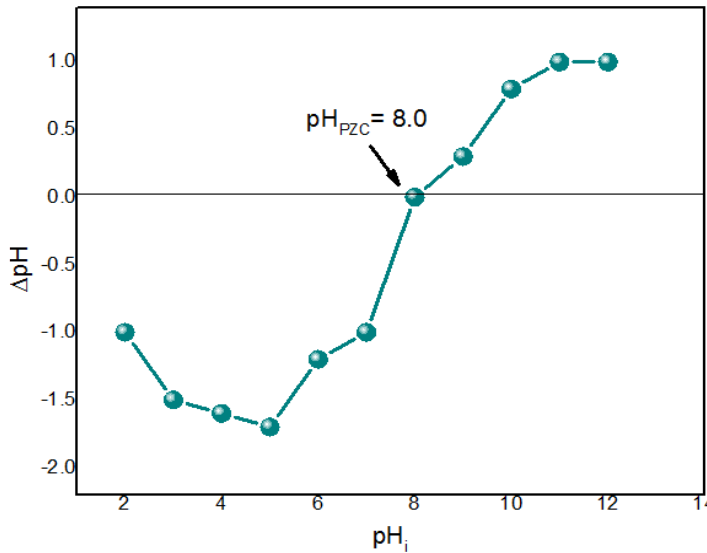
Figure 6. Point of zero charge (pH PZC ) of AC@PIN composites.